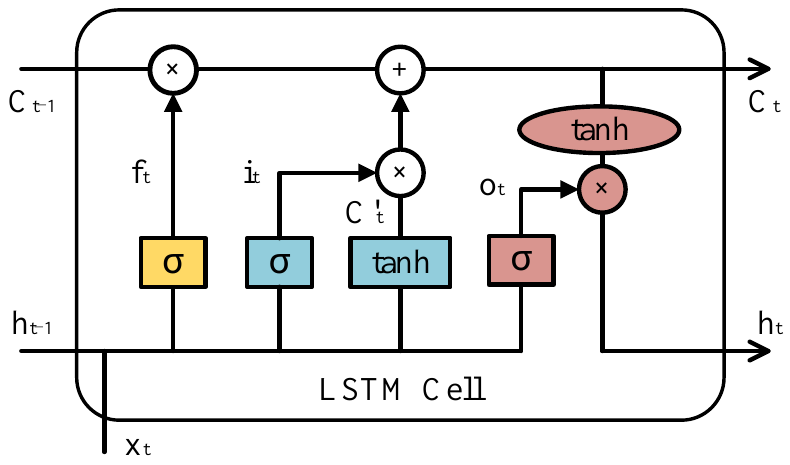
Figure 3. The construction of the LSTM